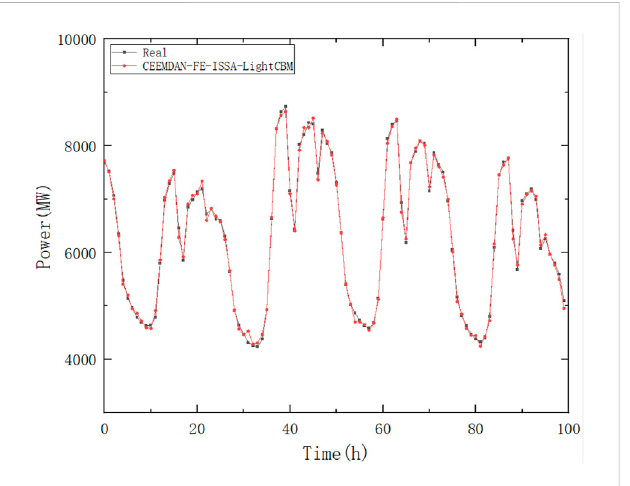
FIGURE 11 Case 1 graph of this paper ’ s model versus the hybrid model.